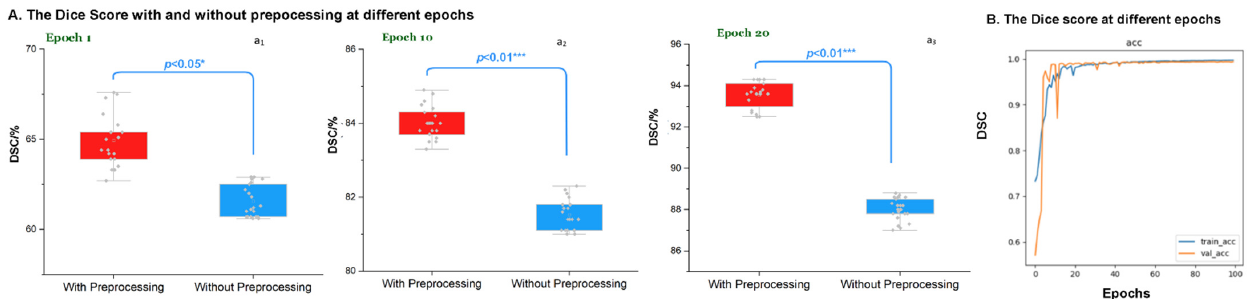
Figure 6. DSC comparison of the modified DCNN at different epochs with and without prepro- cessing of the superpixel. ( A ) The DSC comparison at different epochs, p values showed that they were significantly different at different epochs: a 1 , a 2 , and a 3 are the results at 1, 10, and 20 epochs with p values of 0.05, 0.01, and 0.01, respectively. ( B ) The Dice Score for accuracy at different epochs, after 20 epochs, the framework became stable.